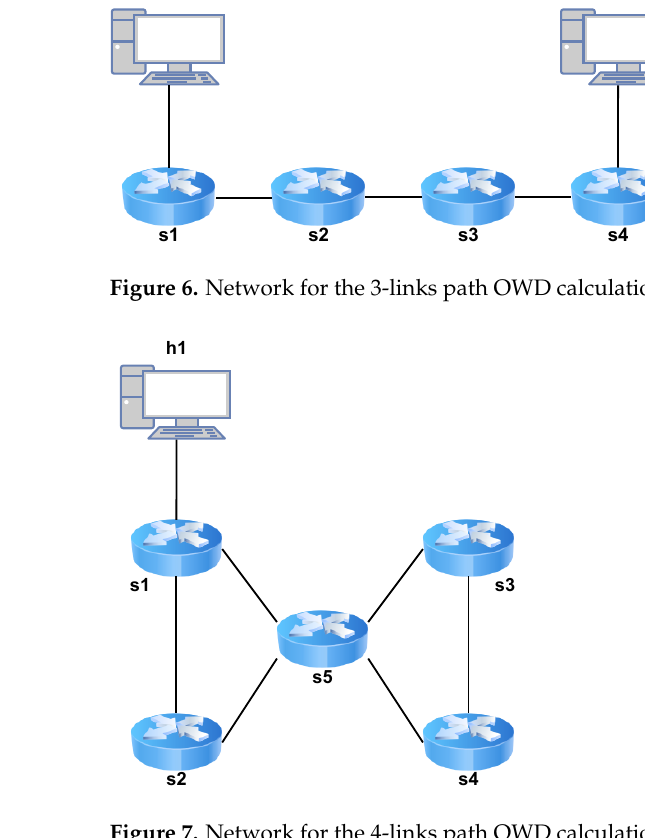
Figure 7. Network for the 4-links path OWD calculation.